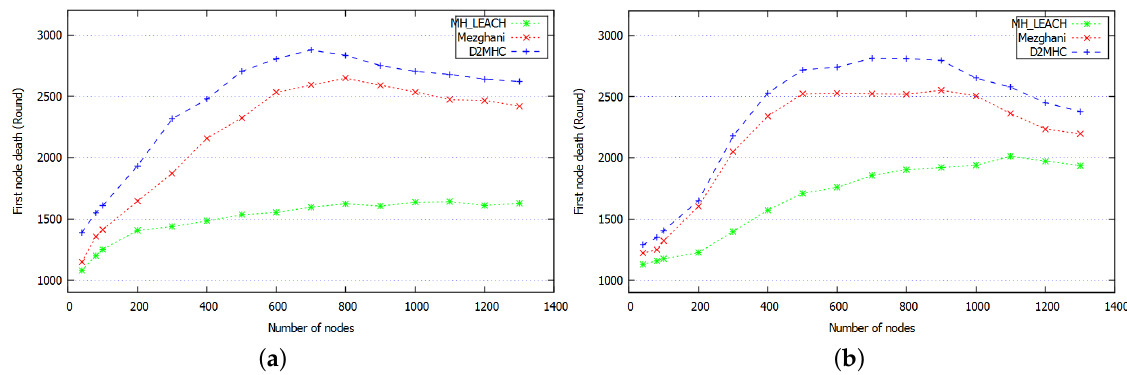
Figure 15. First node death according to different nodes density with ( a ) single-hop, ( b ) multi-hop.